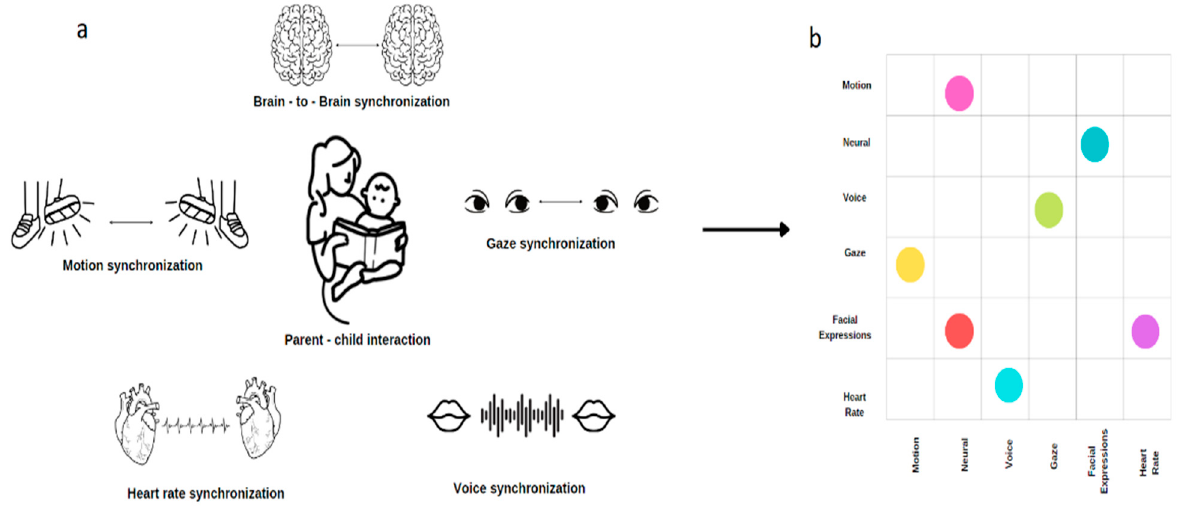
Figure 1. Creation of child–parent interaction synchronization (CHIPS) matrix. ( a ) Mother–child synchronization within different modalities: brain-to-brain, voice, eye contact, motion, heart rate and facial expressions synchronization; ( b ) each modality signal is taken into account in order to create a synchronization (CHIPS) matrix that shows the relation/correlation between the different signals